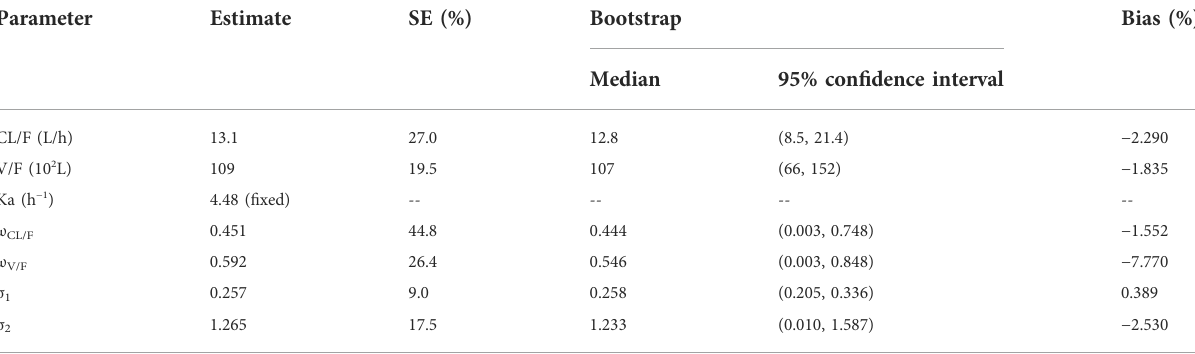
TABLE 2 Parameter estimates of fi nal model and bootstrap